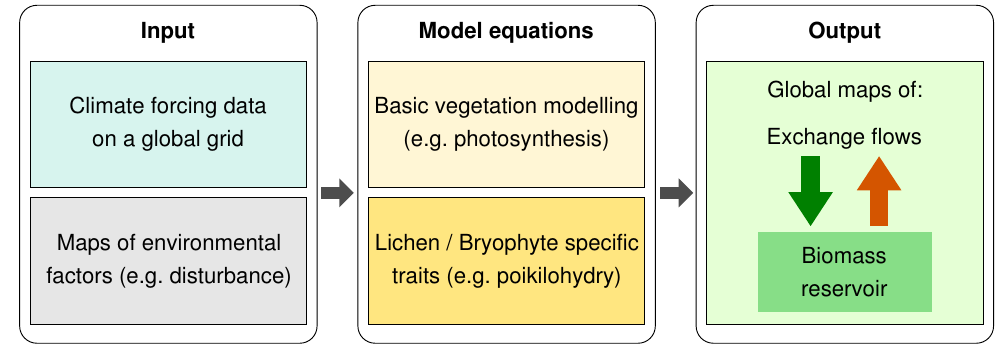
Figure 1: Overview of the functioning of the model. Input data are translated via model Fig. 1. Overview of the functioning of the model. Input data are translated via model equations into exchange flows of carbon, which are equations into exchange flows of carbon, which are used to calculate changes in the biomass used to calculate changes in the biomass reservoir.